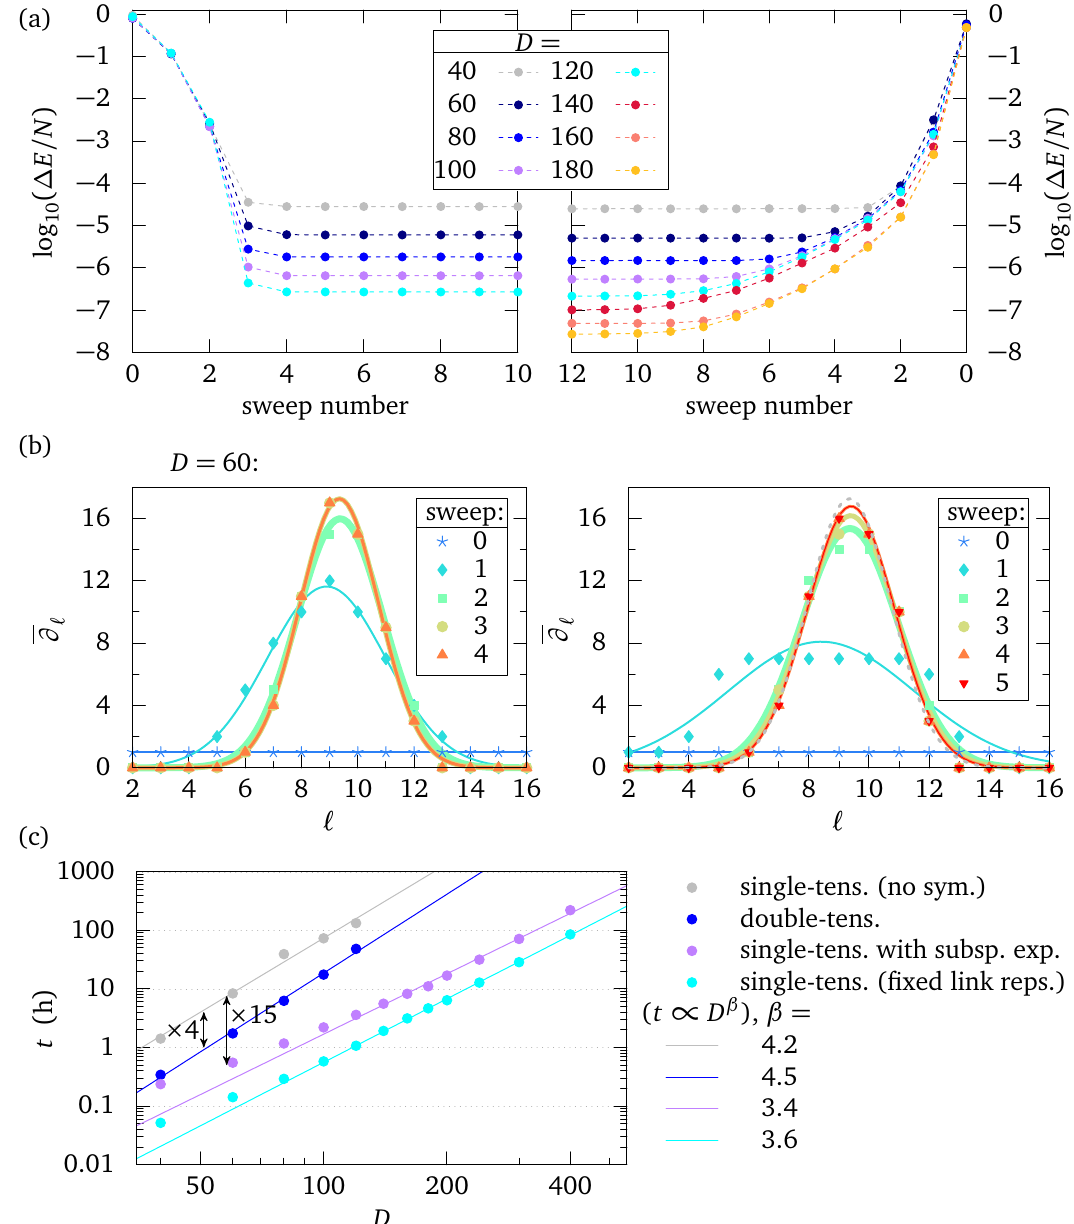
Figure 55: Benchmark of different bTTN algorithm types for a Bose–Hubbard ring = 19, β/ t = 1, U / t = 10, Ω = 0, local bosonic with a rotating barrier ( N = 128, N b state spaces truncated to d = 5). (a) Comparison of ground state energy convergence between double-tensor update (left) and single-tensor update with subspace expansion (right). As reference for the calculation of the error ∆ E the energy from a simulation with bond dimension D = 400 has been used. (b) Degeneracy dimensions convergence at the top link of the bTTN, shown for the same two algorithms as in (a). The solid lines are fitted Gaussians, the gray dashed line in the right plot is the final configuration from the left, for ease of comparison. (c) Algorithm runtimes as a function of the bond dimension. The cyan line corresponds to a single-tensor update with fixed degeneracy dimensions ¯ ∂ (cid:96) (equipped with the converged ¯ ∂ (cid:96) obtained from the single-tensor update with subspace expansion) and demonstrates that the subspace expansion (purple line) adds a comparatively small